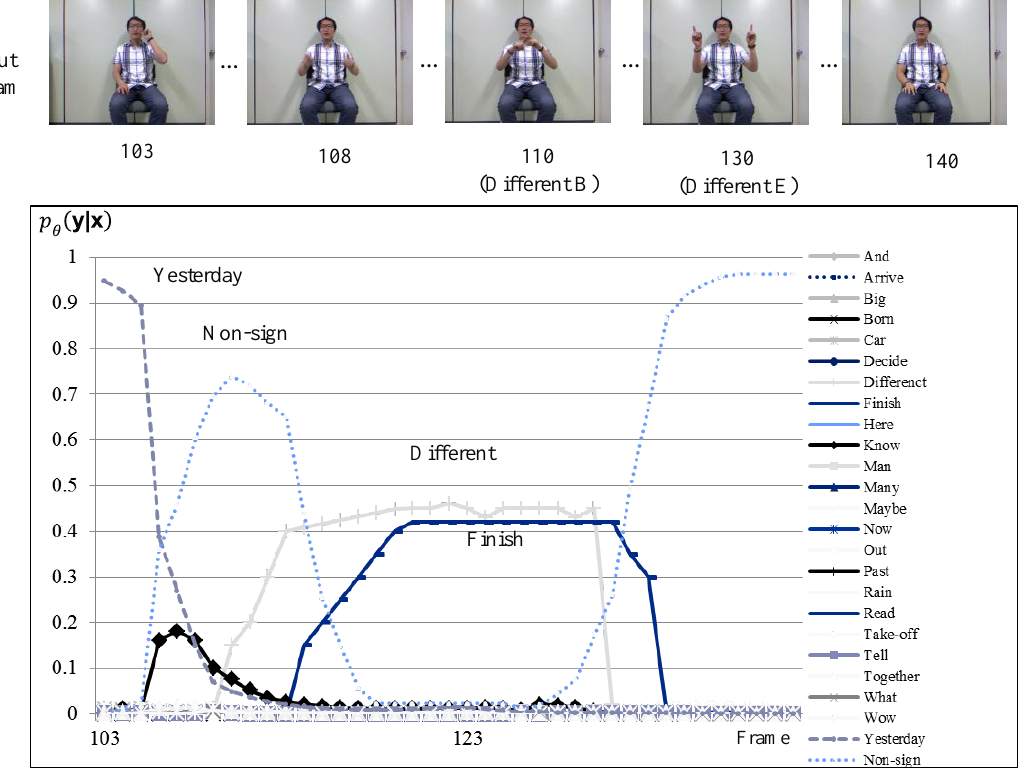
Figure 8. Sign language recognition result for H-CRF 𝟑𝑫 using a signed sentence that includes the sign